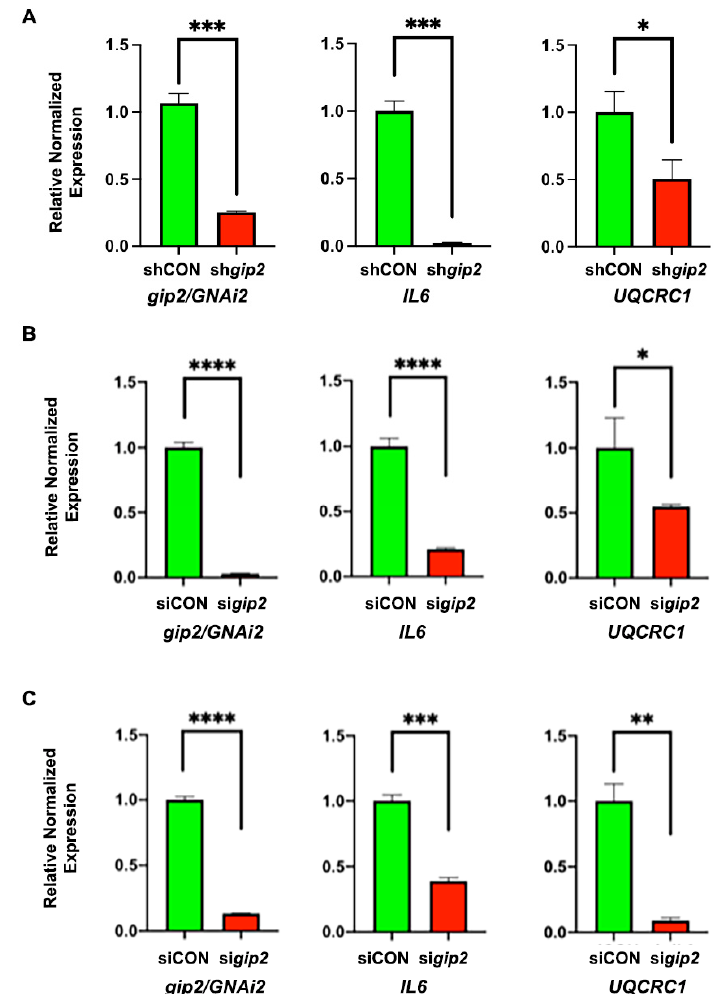
Figure 3. Validation of gip2-dependent hub and bottleneck genes. Downregulation of Hub and Bottleneck node genes upon silencing of gip2 was validated using SKOV3 ( A ), OVCAR8 ( B ) and OVCAR3 ( C ) cells in which the expression of gip2 was silenced using specific shRNA (SKOV3) or siRNAs (OVCAR8 and OVCAR3). In the case of SKOV3 cells, cells expressing non-targeting scrambled RNA were used as control group (shCON). In OVACR8 and OVCAR3 cell, cells transfected with non-targeting scrambled siRNA pool were used as the control group (SiCON). Downregulated genes were validated by monitoring the expression of the representative bottleneck gene IL6 and hub gene UQCRC1. Statistical significance was determined by Student’s t -test (* p < 0.05, ** p < 0.005, *** p < 0.0005, **** p < 0.0001).